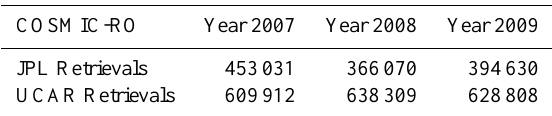
Table 1. COSMIC RO Soundings from JPL and UCAR Data Cen-